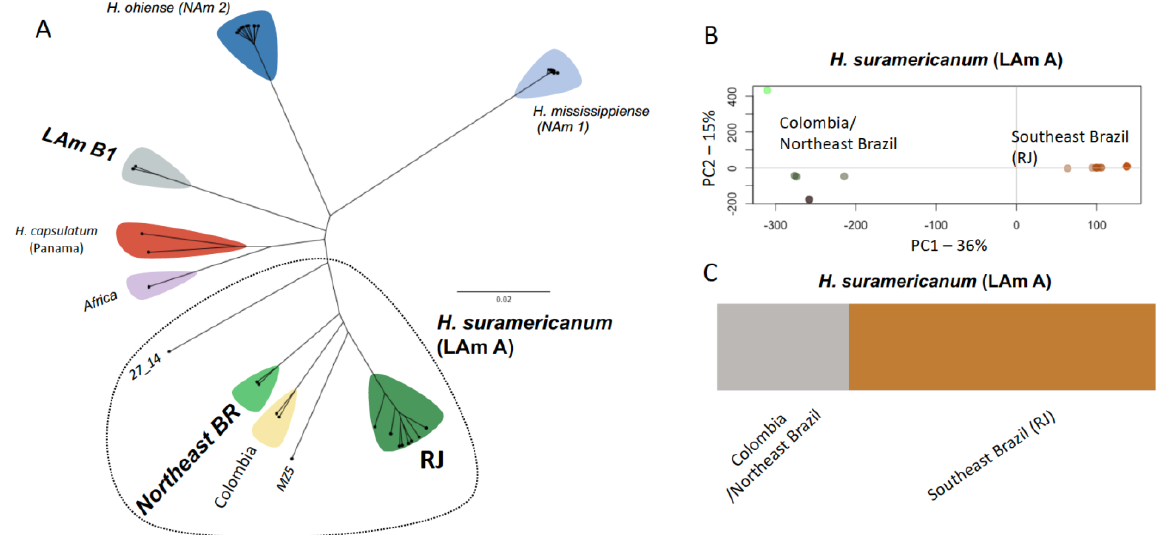
Figure 1. Genomic diversity of Histoplasma sp. collected from a single Research Institute in Rio de Janeiro/Brazil. ( A ) Unrooted Maximum Likelihood tree based on 1,470,938 SNPs indicating the existence of three genotypes: RJ, Northeast BR, and LAm B1. ( B ) Principal coordinate analysis (PCA) showing the population structure of H. suramericanum . The PC1 axis, which corresponds to 36% of the total genetic variation, discriminates the isolates from RJ (Southeast Brazil) and Colombia/Northeast Brazil. ( C ) Admixture analysis of H. suramericanum showing strong population between isolates from RJ and Colombia/Northeast. No admixture was observed between those two main groups of H. suramericanum.